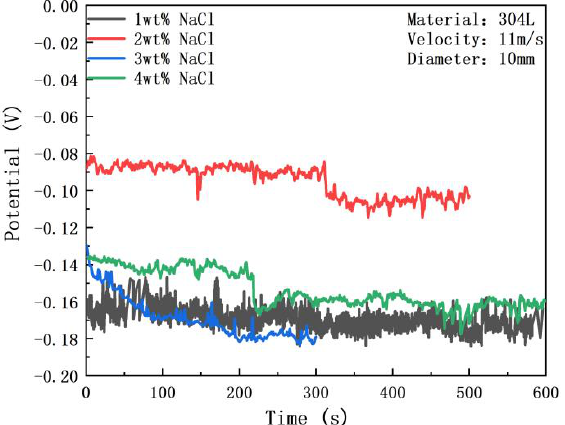
Figure 5. Open-circuit potential of specimens in NaCl solutions with different concentrations.